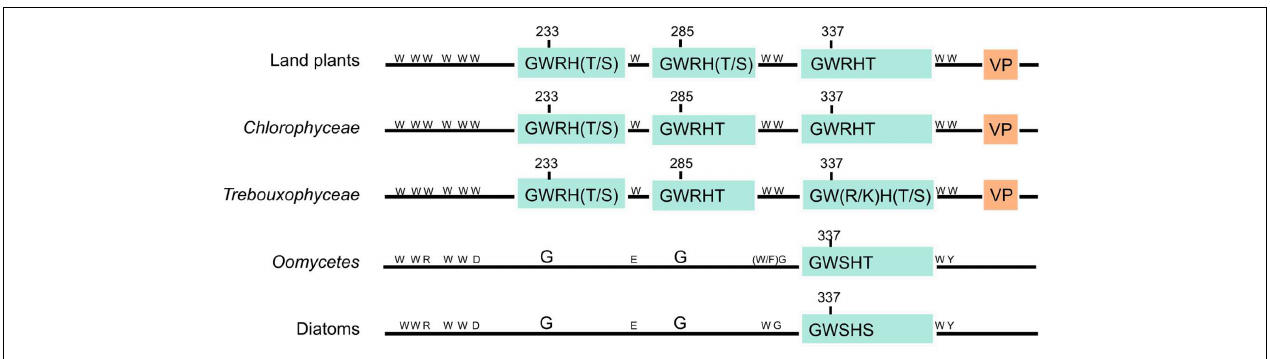
FIGURE 2 | Structural organization of At UVR8 homologs. The schematic domain structure organization of Arabidopsis thaliana UVR8 homologs is represented for land plants, Chlorophyceae and Trebouxiophyceae taxons. Groups with proteins showing an identity lower than 40% to At UVR8 and containing six/seven tryptophans, corresponding to Oomycetes and diatoms, are also shown. Light blue boxes represent the three “GWRHT” motifs containing tryptophans 233, 285, and 337 involved in UV-B perception; orange boxes represent the “VP” domain which contributes to UVR8–COP1 interaction. The fourteen tryptophan amino acids characteristic from At UVR8 and substitutions are indicated in the amino acid one letter